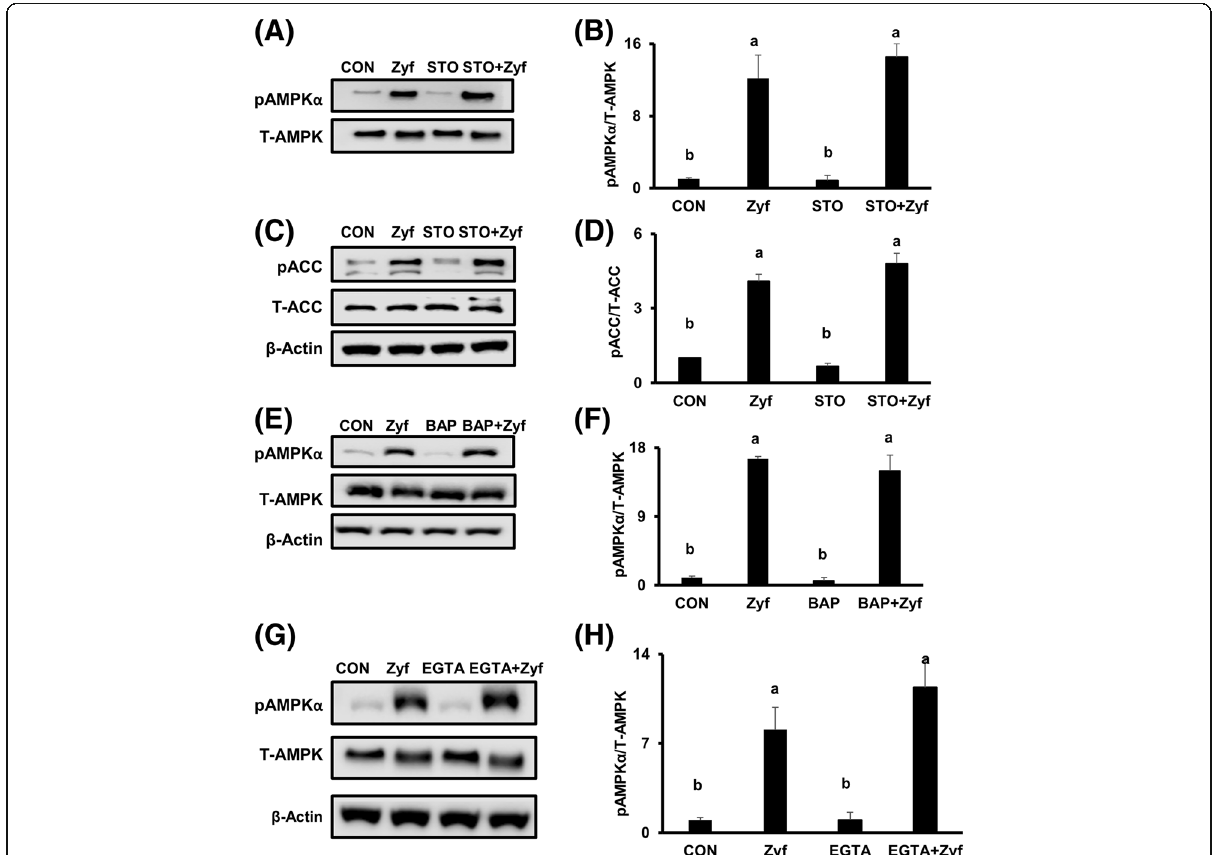
Fig. 3 The effects of CaMKK2 inhibition by STO-609, BAPTA-AM and EGTA on pAMPK α (at Thr172) and pACC (at Ser79), ± Zyflamend in CWR22Rv1 cells. ( A - D ) Western blot of pAMPK α and pACC following treatment of STO-609 (10 μ M, 30 min) ± Zyflamend (200 μ g/mL, 30 min). ( E